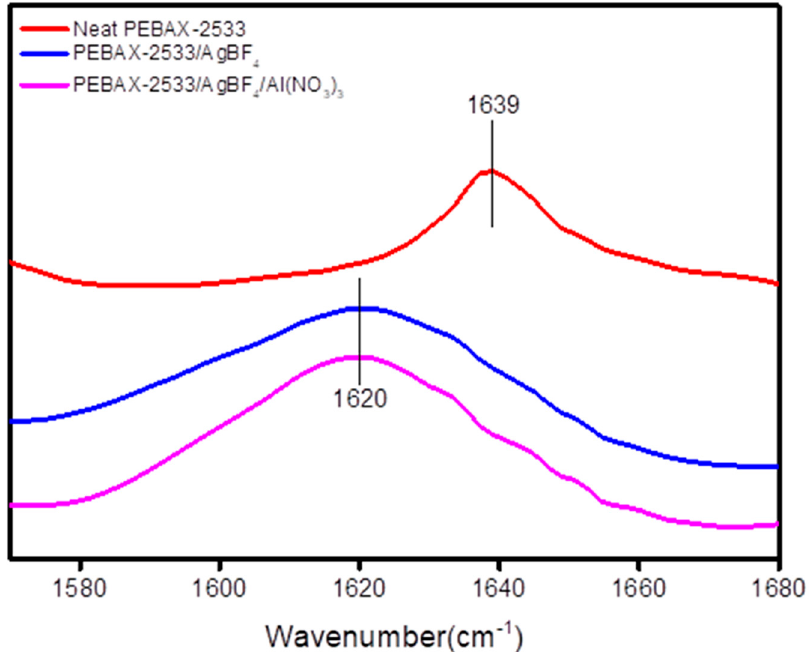
Figure 3. FT-IR spectra of carbonyl group peaks of neat PEBAX-2533, PEBAX-2533 / metal salt and PEBAX-2533 / metal salt / Al